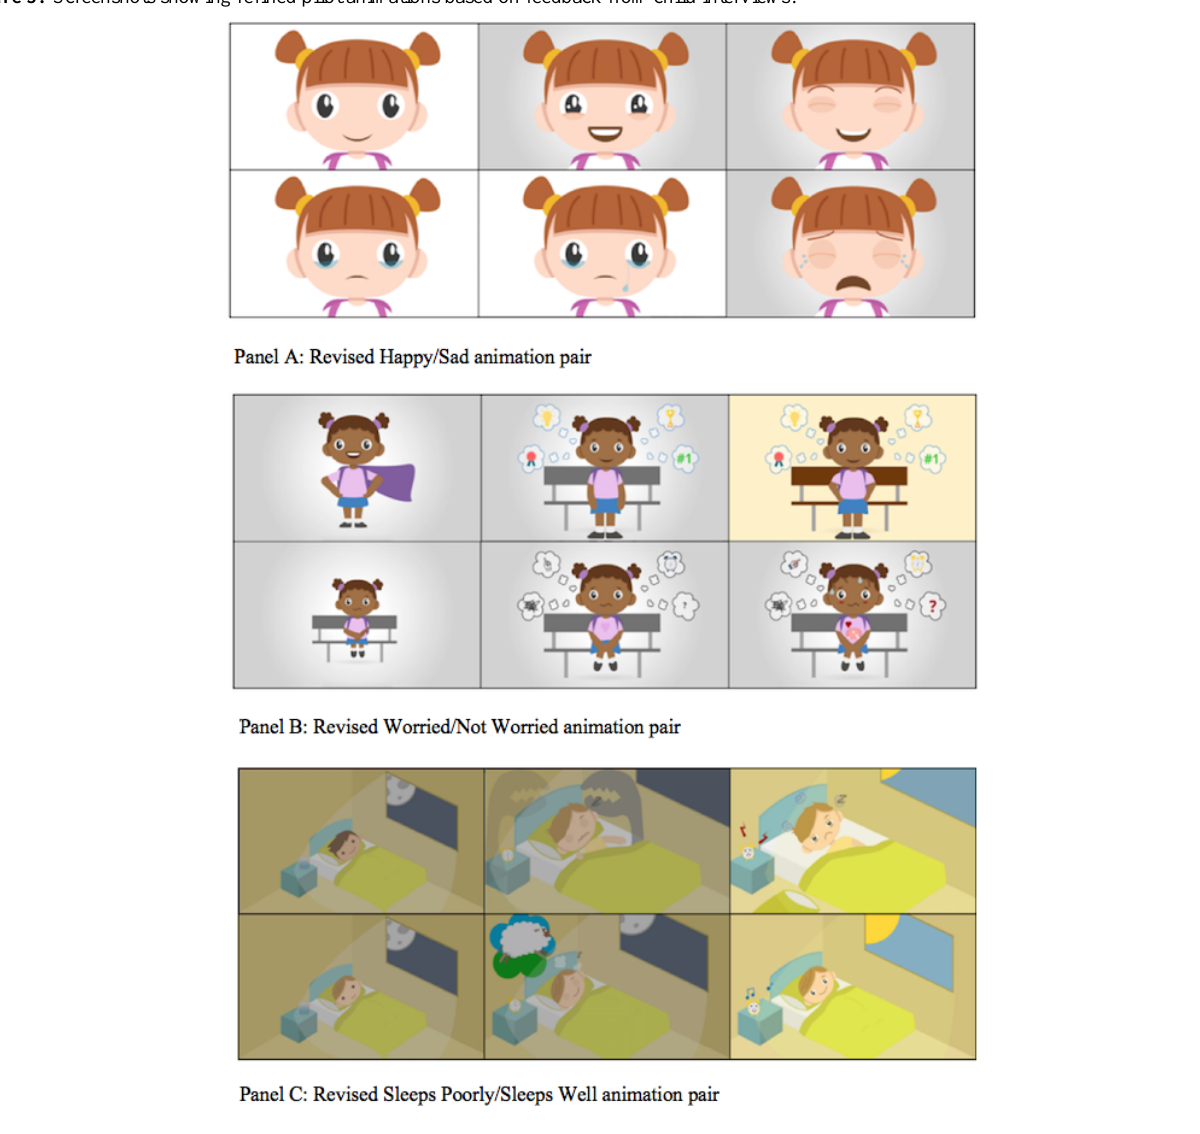
Figure 3. Screenshots showing refined pilot animations based on feedback from child